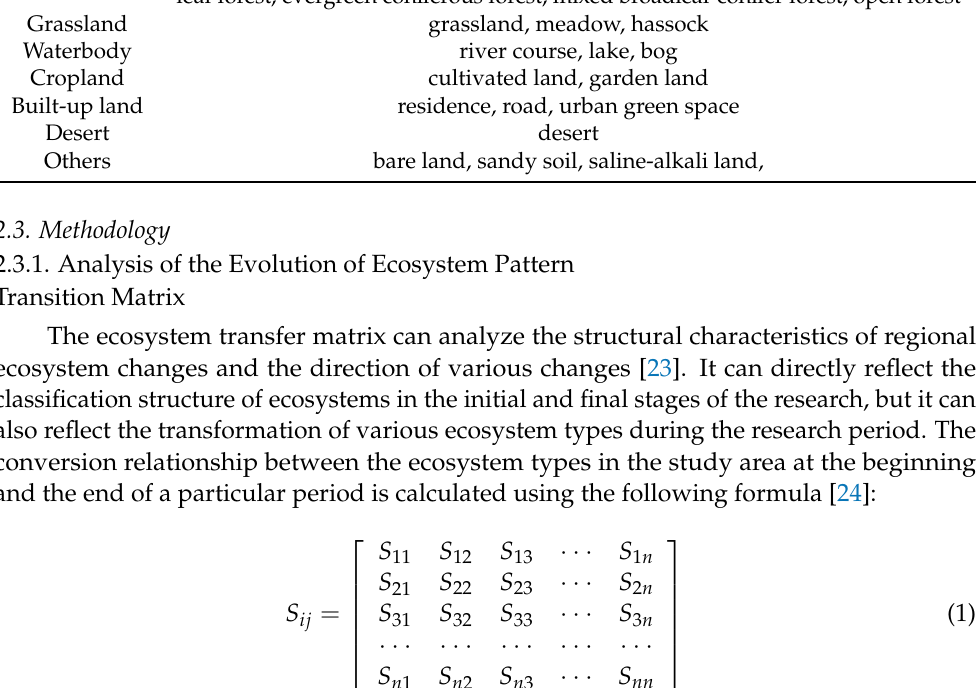
Table 2. Classification system of first-class of LPES. Ecosystem Description Forest